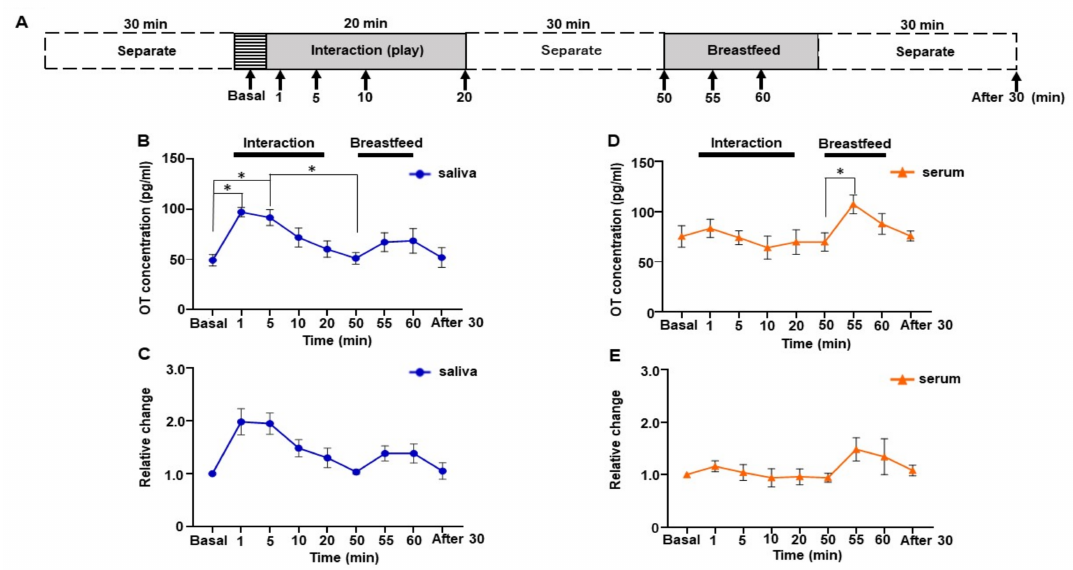
Figure 4. Changes in saliva and serum oxytocin (OT) concentrations during the direct mother- infant interaction test of one woman. ( A ) Schematic procedure of the interaction test. ( B ) Saliva OT concentration. ( C ) Relative changes in salivary OT. ( D ) Serum OT concentration. ( E ) Relative change in serum OT. The experiment was repeated six times with one mother (n = 6). Values are the means of six repeated experiments and are the means ± SEM; one-way repeated measures ANOVA (d.f. = 8; * p < 0.05).